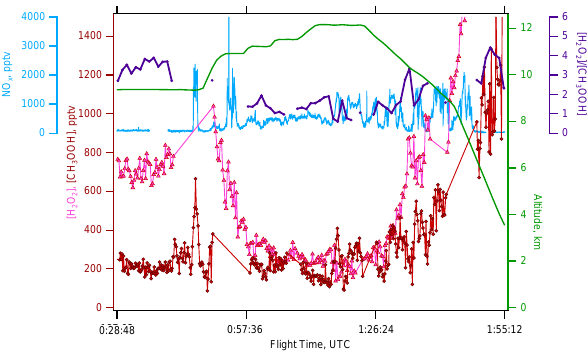
Fig. 5. Expanded view time series plot for peroxides, NO x and altitude for event